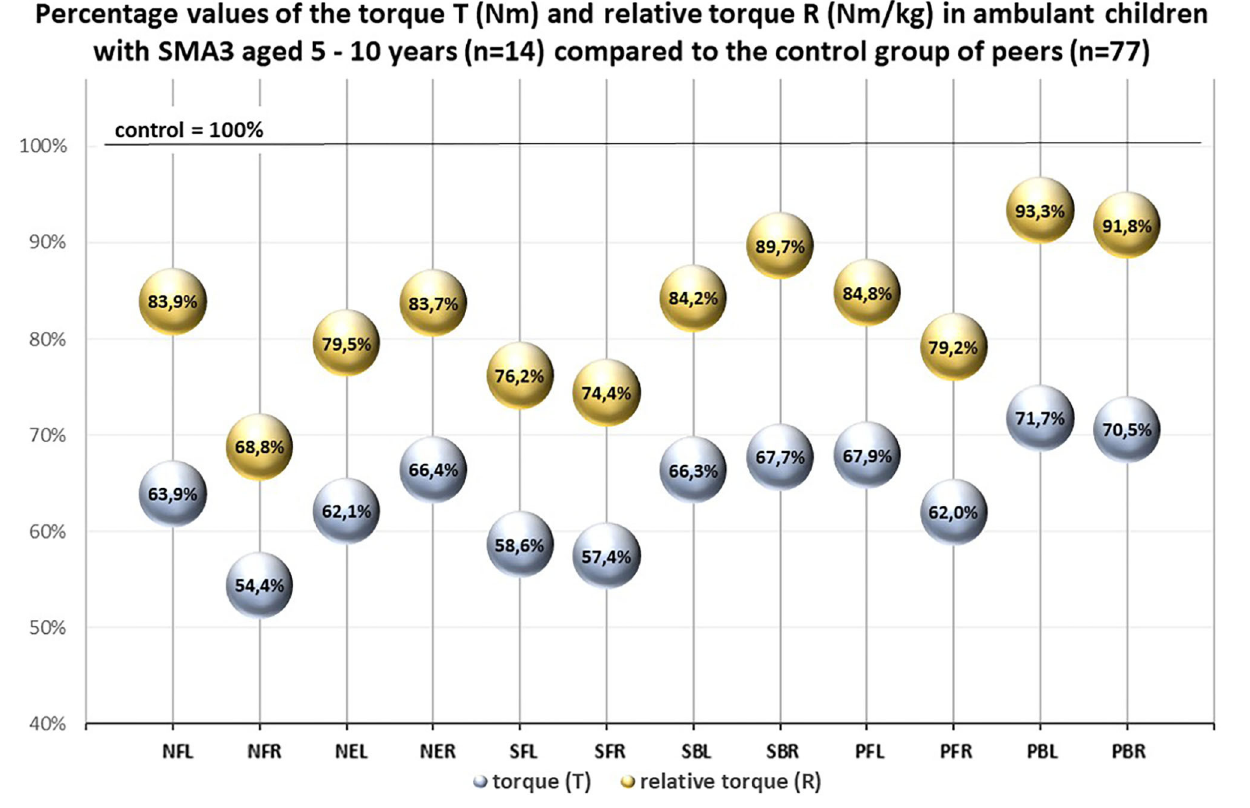
FIGURE 4 | Percentage values of the torque T (Nm) and the relative torque R (Nm/ kg) in ambulant children with SMA 3 aged 5–10 years ( n = 14) compared to the control group of peers ( n =